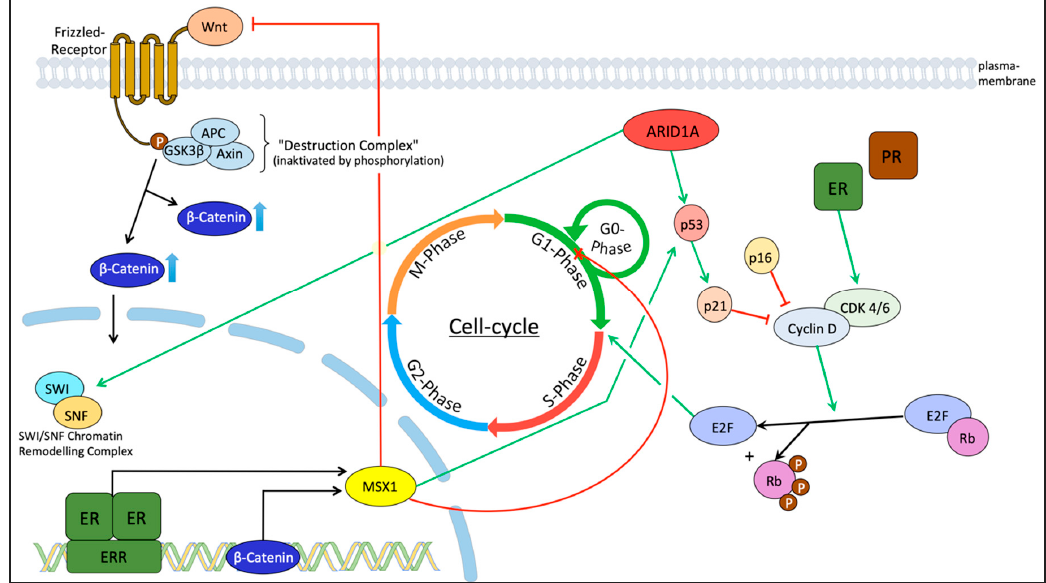
Figure 6. The function of MSX1 in relation to prognostic markers found in our former